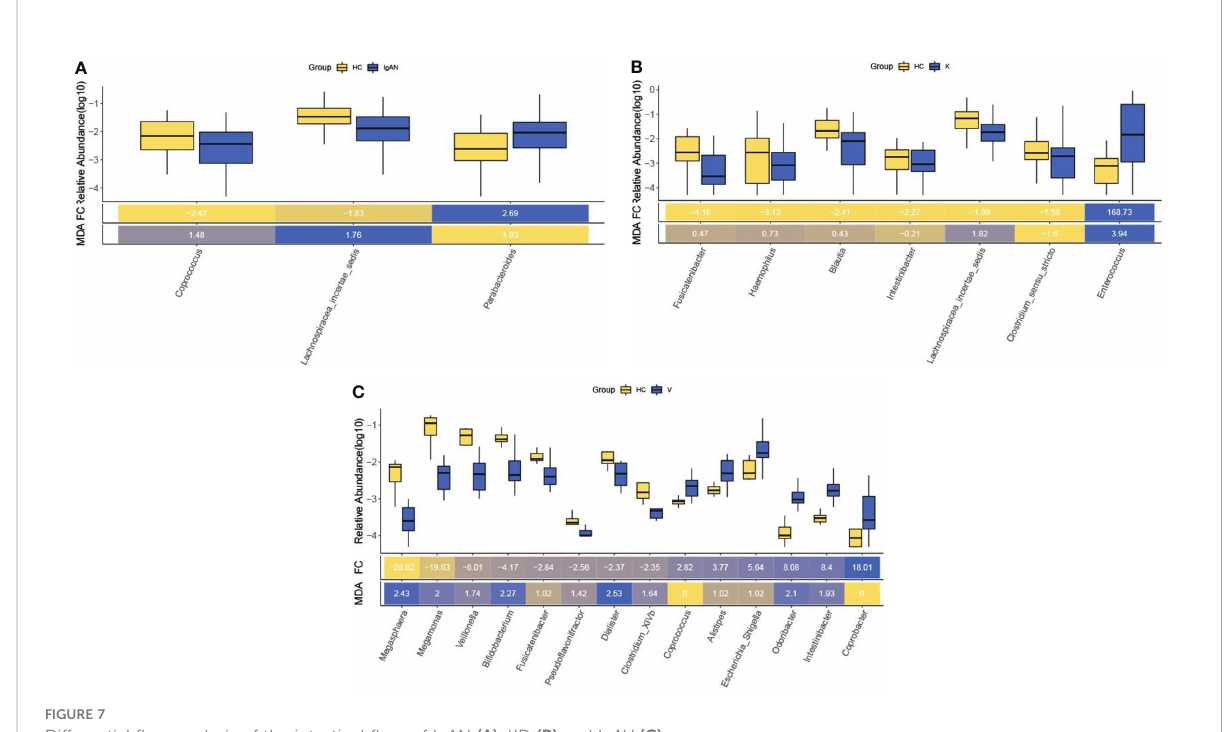
FIGURE 7 Differential fl ora analysis of the intestinal fl ora of IgAN (A) , KD (B) and IgAV (C) .